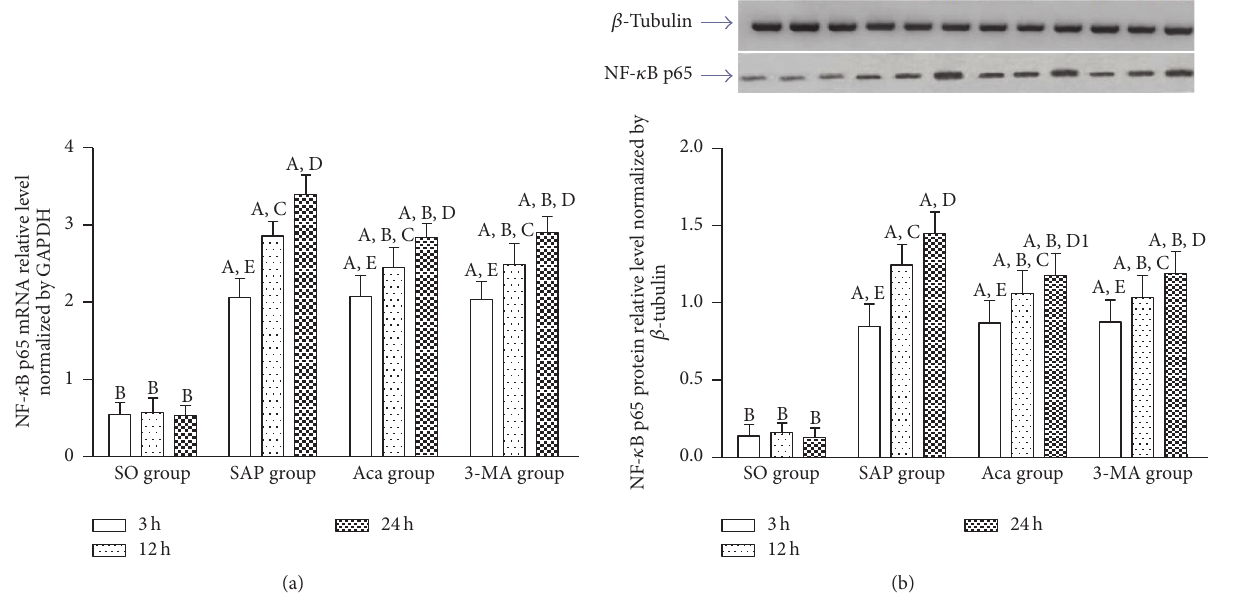
Figure 6: The expression of nucleus NF- 𝜅 B p65 mRNA (a) and protein (b) levels in the pancreas tissue at 3, 12, and 24 h in four groups. A 𝑃 < 0.01 versus SO group at the same time point; B 𝑃 < 0.01 versus SAP group at the same time point; 12h versus 3h in the same group, C 𝑃 < 0.01 ; 24 h versus 12h in the same group, D 𝑃 < 0.01 ; D 1 𝑃 < 0.05 ; 24 h versus 3 h in the same group, E 𝑃 < 0.01 . 1: SO-3 h; 2: SO-12 h; 3: SO-24 h; 4: SAP-3 h; 5: SAP-12h; 6: SAP-24 h; 7: Aca-3 h; 8: Aca-12 h; 9: Aca-24 h; 10: 3-MA-3 h; 11: 3-MA-12h; 12: